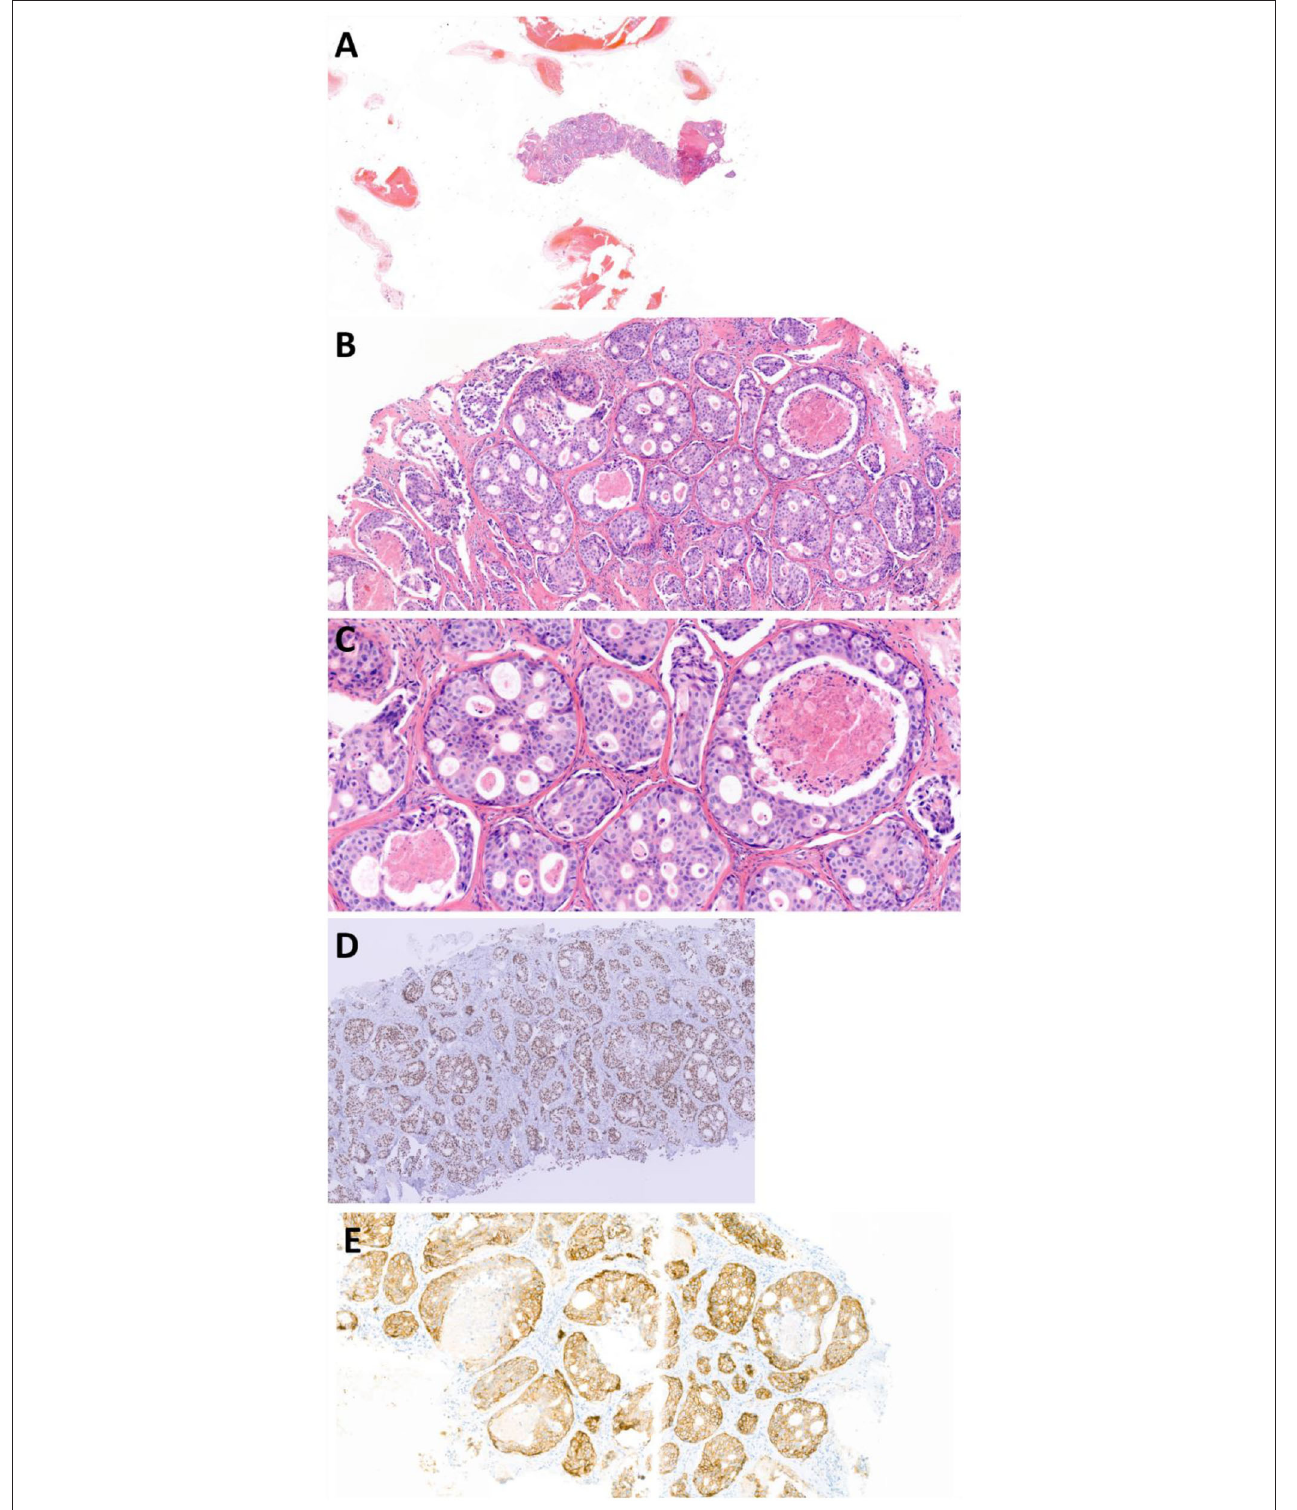
FIGURE 5 | Photomicrographs of case report 2: biopsy of SDC bone metastasis in thoracic vertebra 3. 1. (A) H&E stain 1X, (B) H&E stain 10X, (C) H&E stain 20X, (D) AR stain 5X (photomicrograph from referring center), (E) HER2neu stain 10X, HercepTest (Dako Agilent).